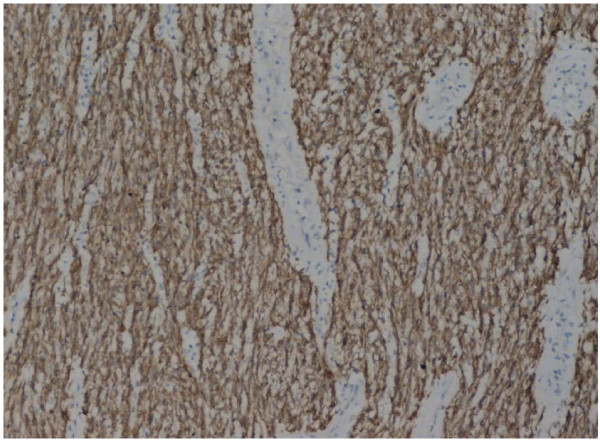
Gatric GIST/C-kit immunoexpression (×40)